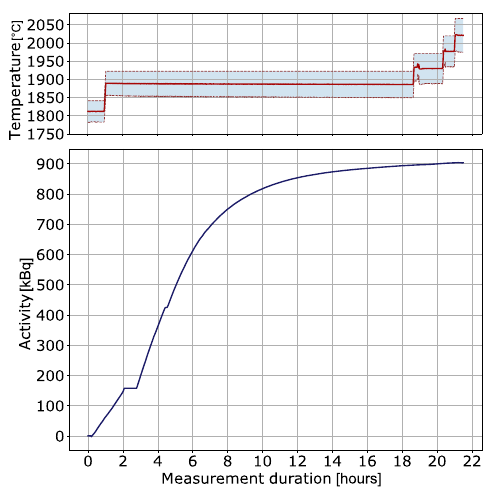
Figure 3. The target temperature and collected activity estimated during